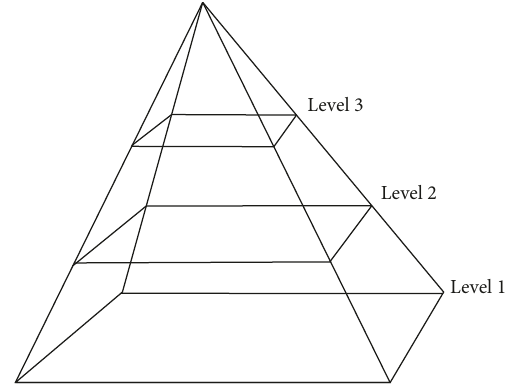
Figure 8: Pyramid hierarchical structure.